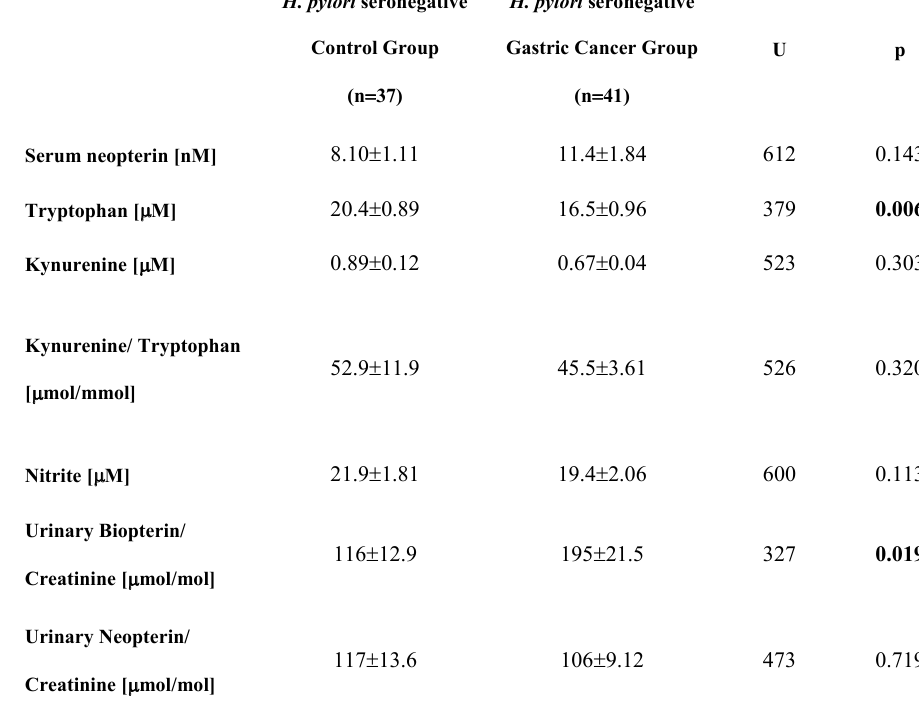
biopterin levels of both control and gastric cancer